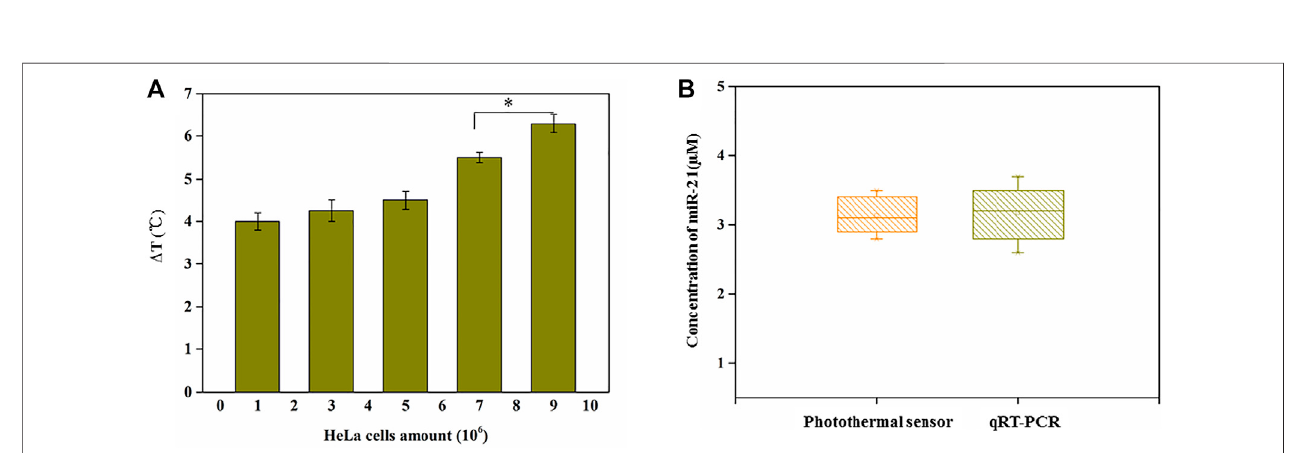
FIGURE 5 | (A) Temperature changes with the endogenous miR21 extracted from different amounts of HeLa cells. An asterisk indicates a statistically signi fi cant difference (* p < 0.05). (B) Detection of miR-21 using current photothermal sensor and qRT-PCR from HeLa cells (concentration: 9 × 10 6 ).